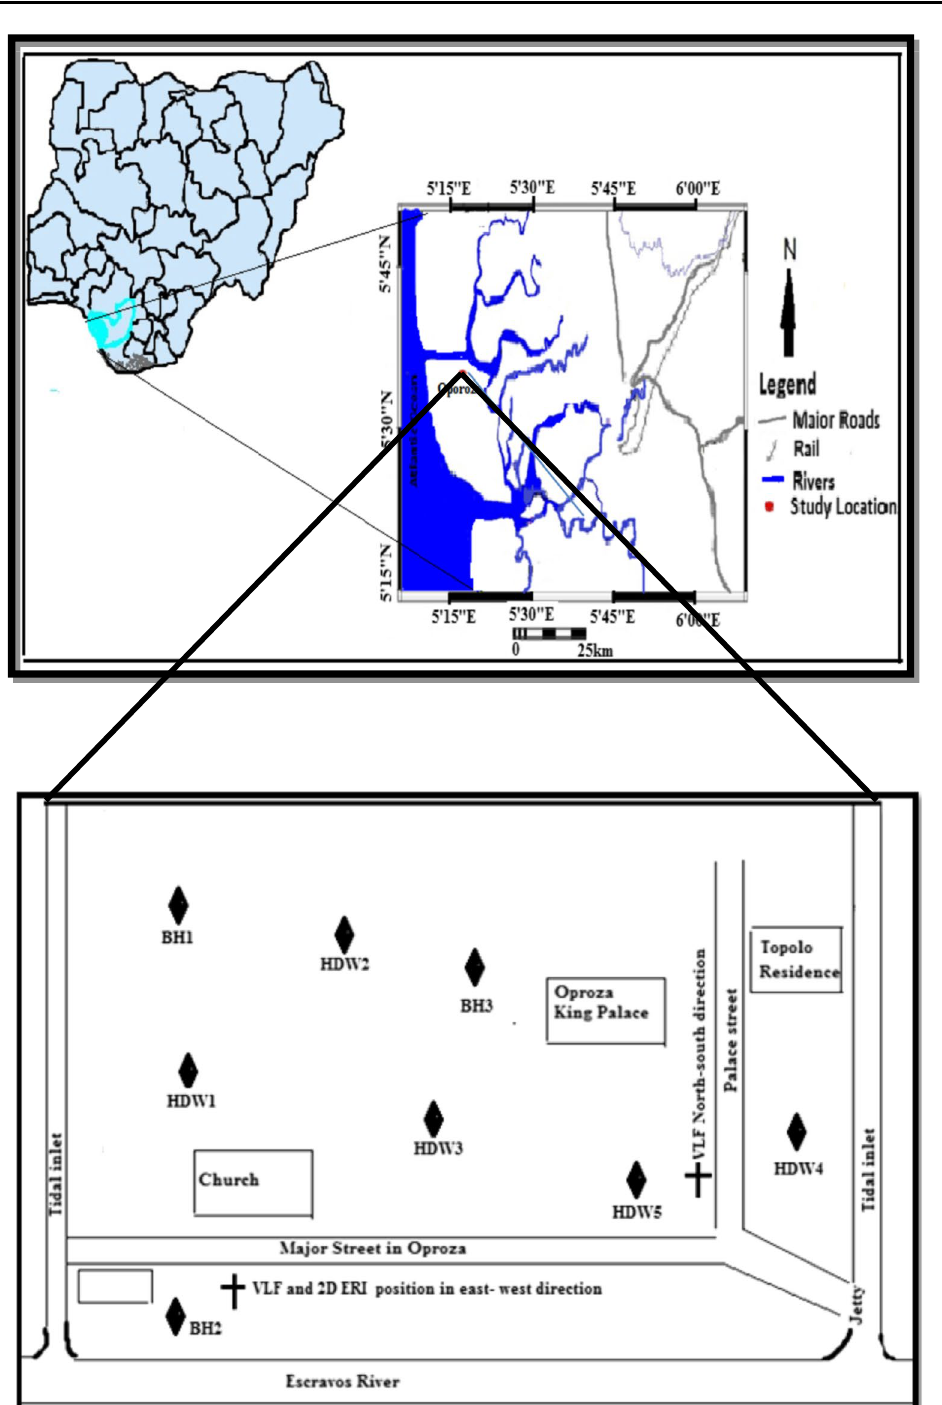
Fig. 1 Map showing study location within the coastal area of the Western Niger